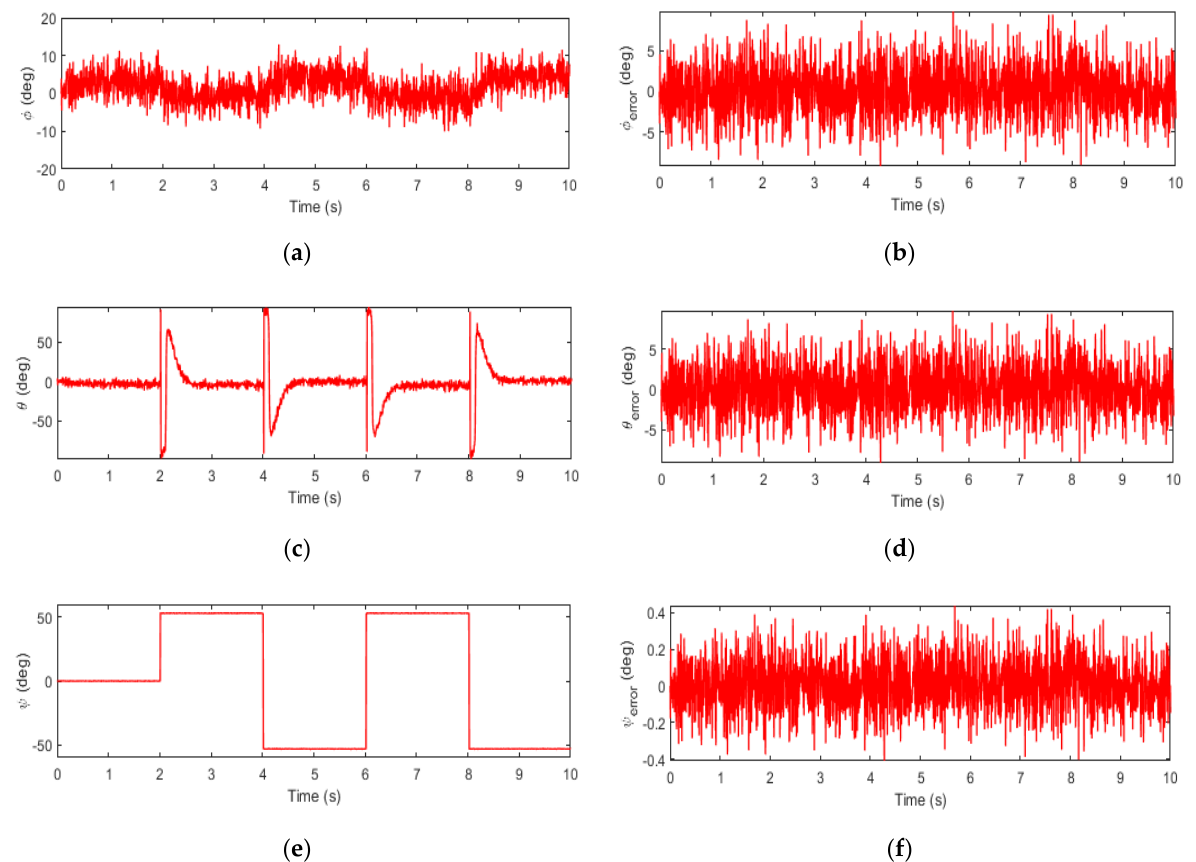
Figure 6. ( a , c , e ) Euler’s angle response of quadrotor. ( b , d , f ) Euler’s angle error between desired and real